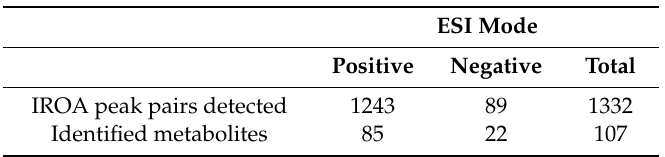
Figure 1. Overview of isotopic ratio outlier analysis (IROA) experimental approach for detecting metabolites whose production is upregulated, downregulated, or exclusive to treatments or controls. This approach was used to evaluate impacts of 2,2 (cid:48) -bipyridyl (bipy) on the N. dassonvillei metabolome. Bipyridyl treatment ( n = 4, T12C) and no-bipyridyl control ( n = 4, C12C) bacteria were fermented in uniformly 95:5 12 C: 13 C-labeled media alongside equivalent standard cultures in 5:95 12 C: 13 C-labeled media. Standard cultures were then pooled to provide an internal standard (IS) mixture containing 13 C-labeled isotopes of every metabolite from T12C or C12C. Each T12C and C12C culture was supplemented with this IS before chemical extraction and UHPLC / MS. The ratio of C12C (blue) or T12C (green) MS signal integrals to corresponding IS signals (magenta) was determined. Statistical comparison of these C12C:IS and T12C:IS ratios enabled determination of metabolites whose production was impacted by bipyridyl treatment. Evaluation of the m / z di ff erence between monoisotopic 12 C- and 13 C-labeled metabolites indicated the number of carbon atoms in each molecule, as illustrated by the IROA peak pair for leucine from N. dassonvillei . Table 1. Summary of N. dassonvillei metabolome revealed by IROA UHPLC / MS. IROA peak pair refers to a pair of molecular ion signals corresponding to a 12 C-labeled metabolite from T12C and / or C12C and its isotopic 13 C-labeled IS. Metabolite identities were proposed from agreement between molecular ion exact masses, IROA-determined number of carbon atoms, and retention times with compounds from a standard